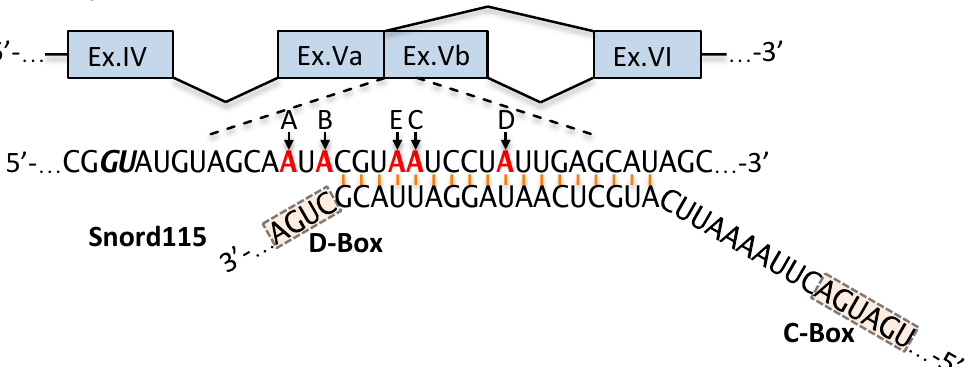
Figure 3. Schematic representation of 5-Ht2cr pre-mRNA exons IV to VI and putative targeting region of Snord115 within exon Vb (drawings are not to scale). Alternative splicing site ( GU ) of 5-Ht2cr pre-mRNA exon Vb is indicated with bold italic letters. A-to-I editing sites A–D are denoted in red and labeled with arrows, accordingly. Snord115 C- and D-boxes are highlighted